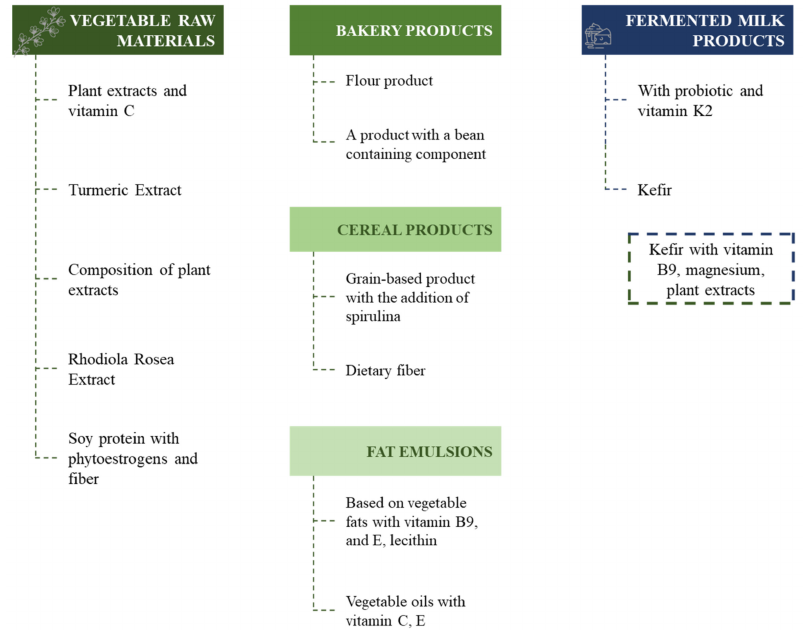
Figure 16. Functional products exhibiting cardioprotective activity found in patent research